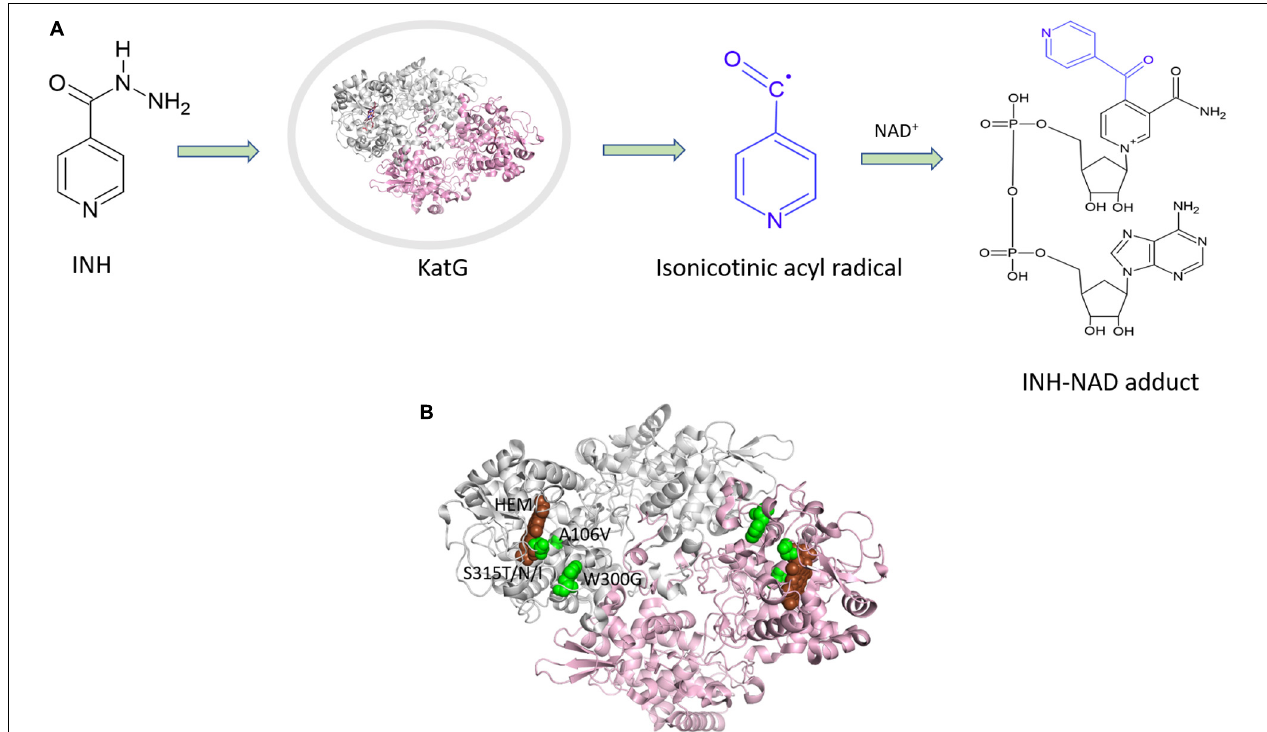
FIGURE 3 | (A) Mechanism of isoniazid activation and INH-NAD adduct formation. (B) Mutations mapped (Munir et al., 2019) on the structure of KatG (PDB ID:1SJ2; Bertrand et al.,